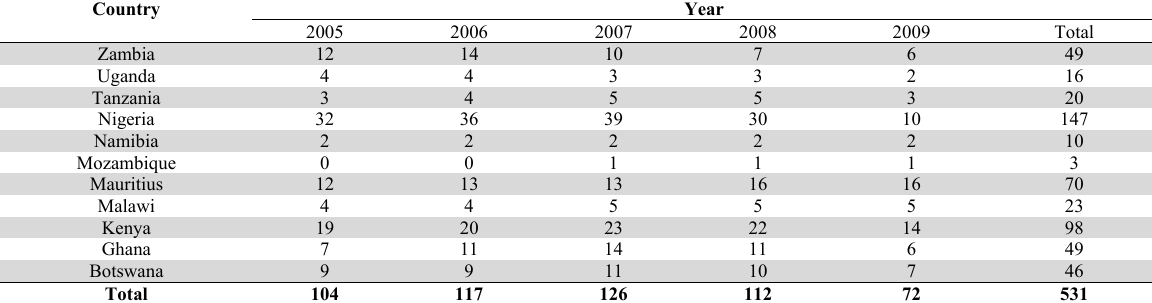
Sample distribution by country and year